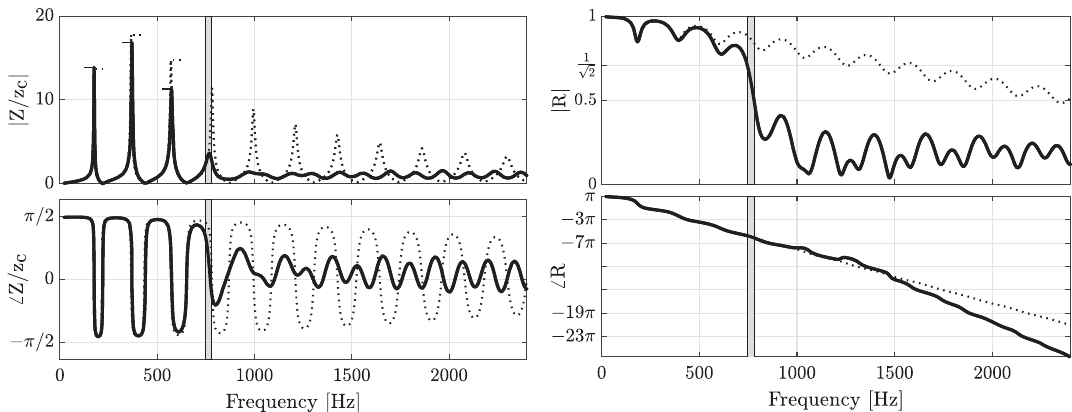
Figure 1. Input impedance (modulus and argument) and re fl ection coef fi cient (modulus and argument) of an acoustically regular conical resonator (solid black lines) with a fi rst impedance peak at 177 Hz and a theoretical global tonehole lattice cutoff frequency at 750 Hz. A conical resonator (dotted lines) with the same fi rst impedance peak frequency but no tonehole lattice is shown for comparison. The fi rst three impedance modulus peaks are marked by a solid black line (resonator with a lattice) and dotted lines (simple cone). The cutoff transition band f R (de fi ned in Sect. 2.4, Eq. (19)) is shown in shaded grey. t